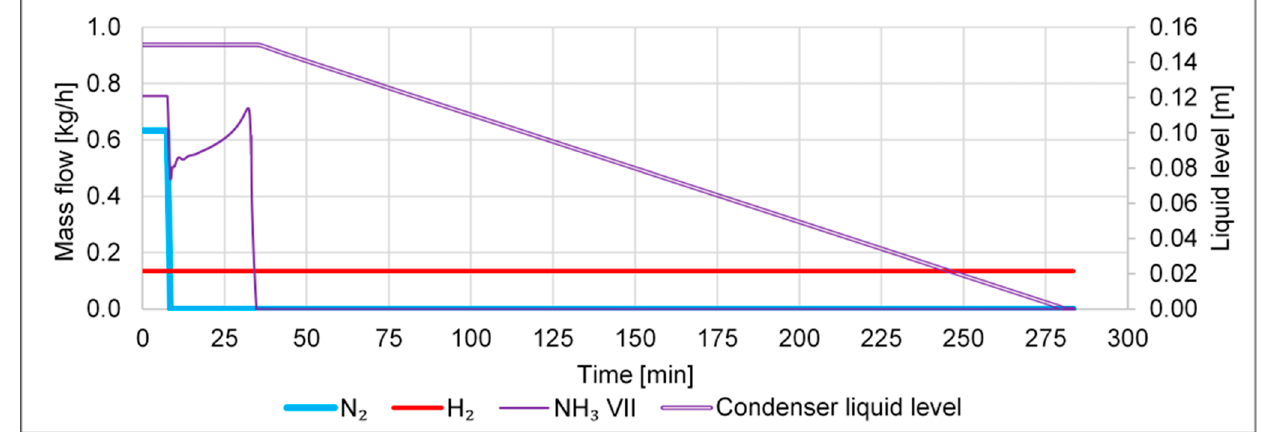
Figure 7 . Selected mass fl ows (left vertical axis) and condenser liquid level (right vertical axis) of Figure 7. Selected mass flows (left vertical axis) and condenser liquid level (right vertical axis) of scenario (c). scenario (c).